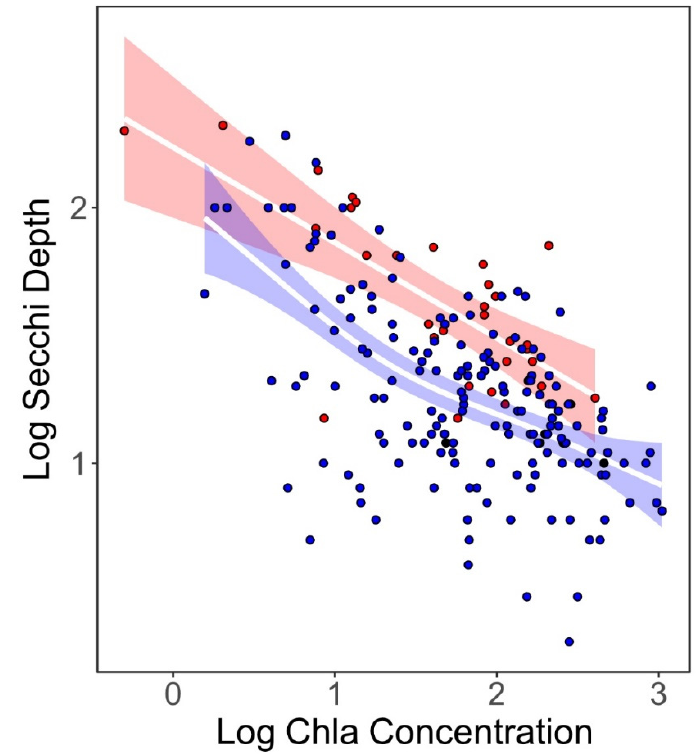
Figure 2. HGAM results for model I, showing fitted trends, confidence intervals, and observed values for data corresponding to the period 1984–1999 (red) and 2000–2021 (blue). Plots are partial plots of